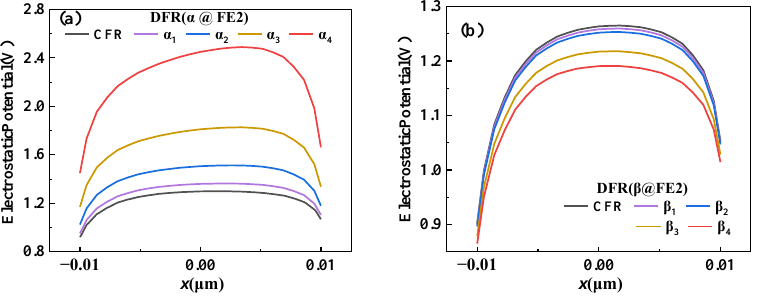
Figure 4. Voltage distribution along the bottom of the ferroelectric region for the CFR-NCFET and DFR-NCFET with ( a ) variable α in FE2 region, ( b ) variable β in FE2 region.